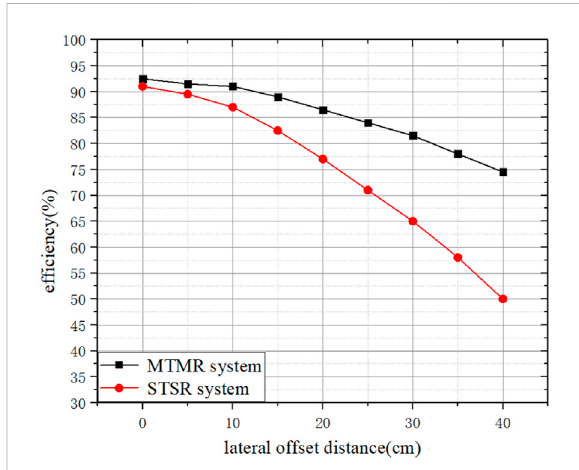
FIGURE 13 Ef fi ciency comparison of MTMR WPT system and STSR WPT system under different offsets.